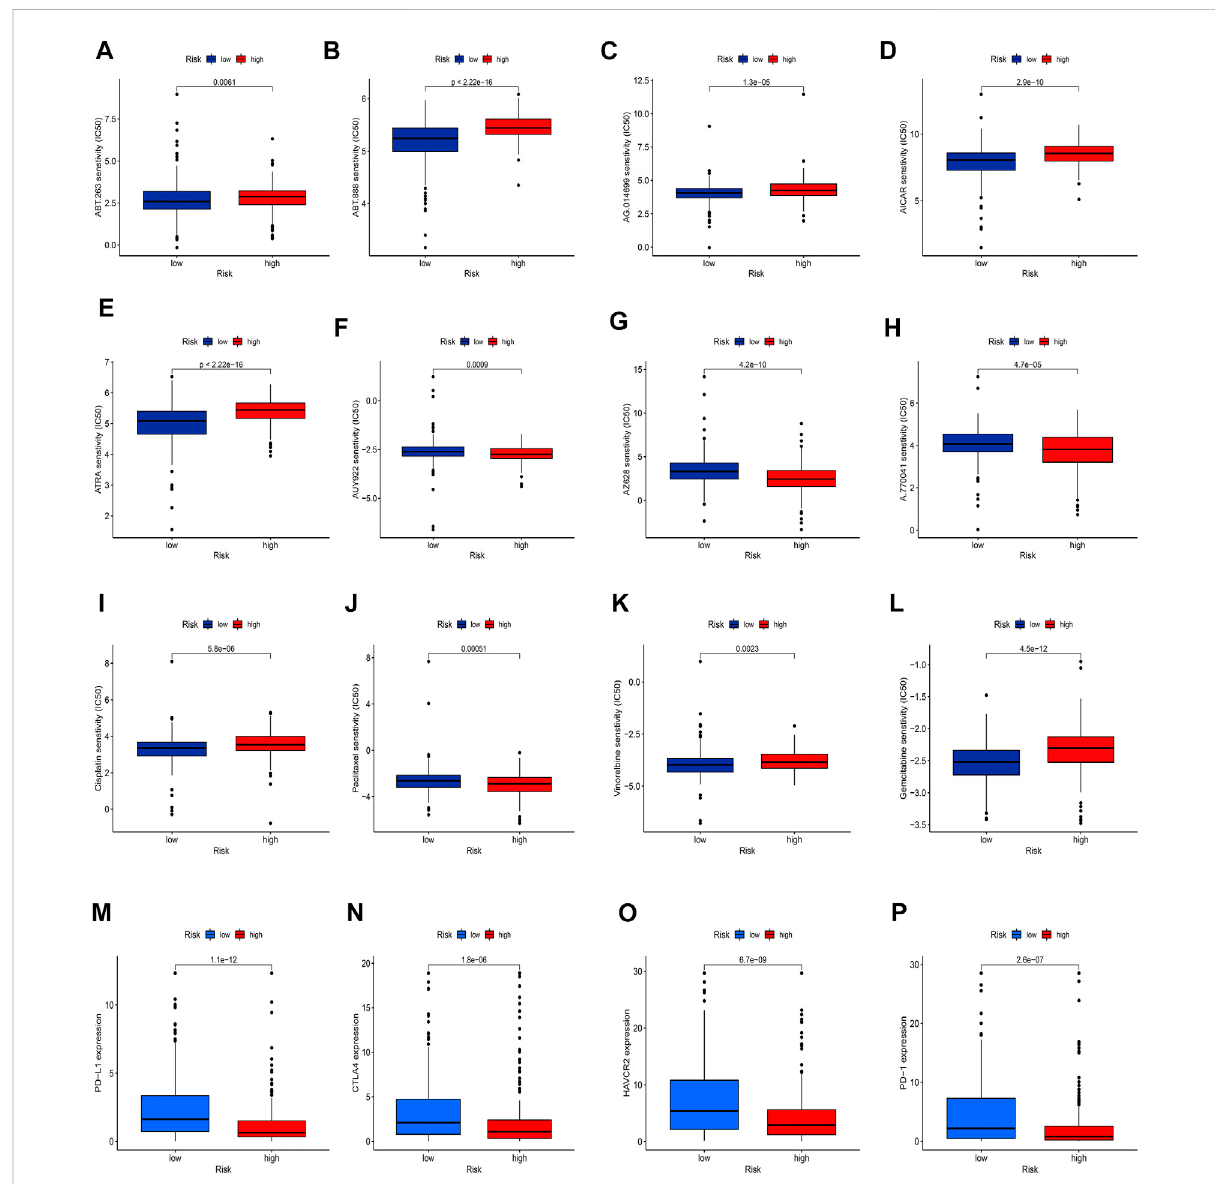
FIGURE 11 Exploration of therapeutic sensitivity. (A – H) Analysis of potential drug sensitivity in two groups. (I – L) Analysis of common chemotherapeutic sensitivity. (M – P) Expression levels of critical ICIs in the two groups. ( p < 0.05 *; p < 0.01 **; p < 0.001